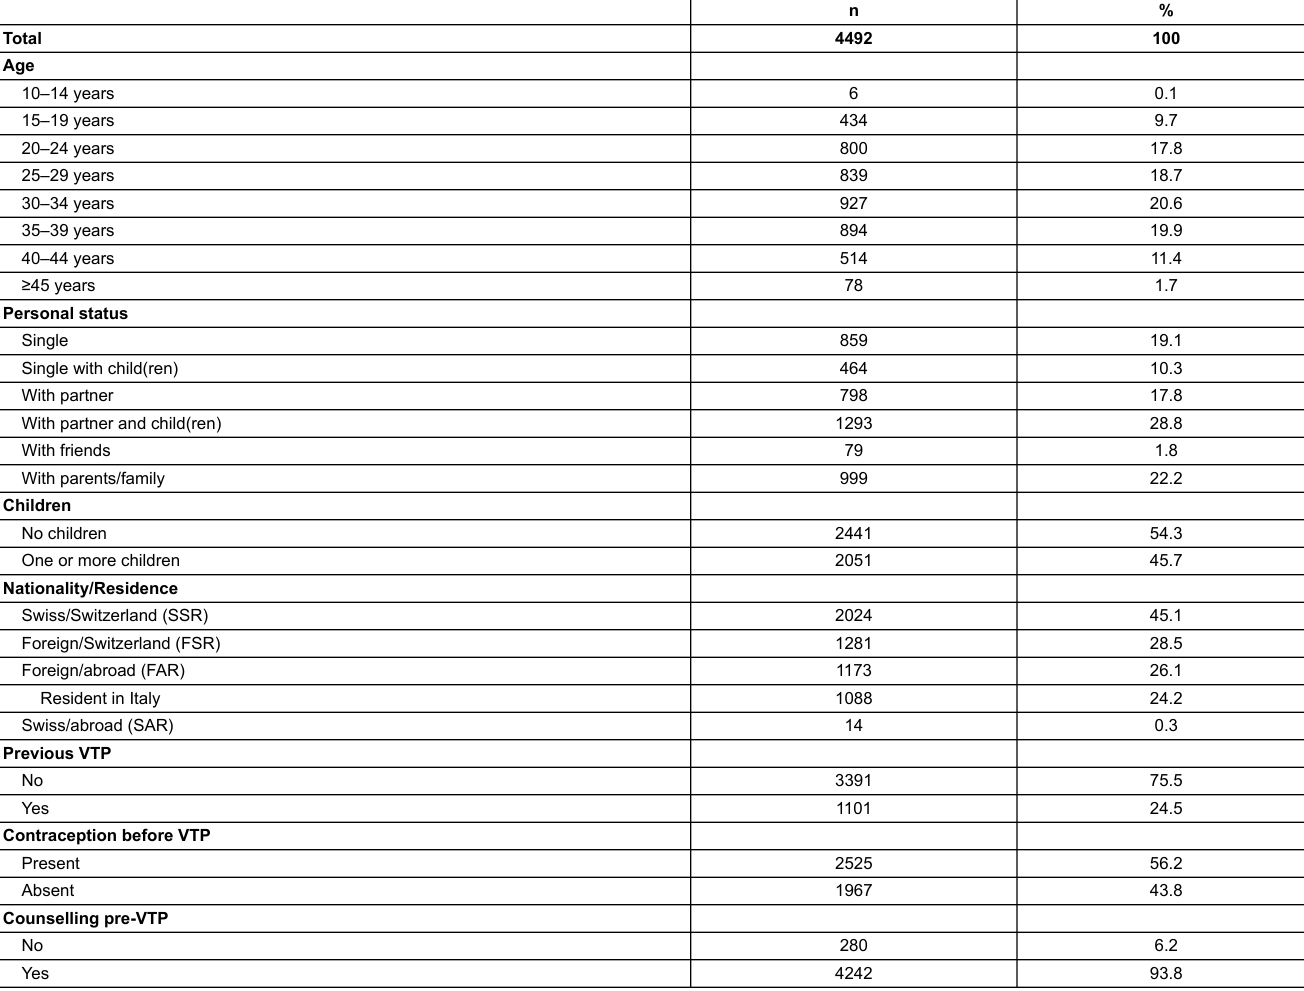
Table 1: Study sample characteristics.